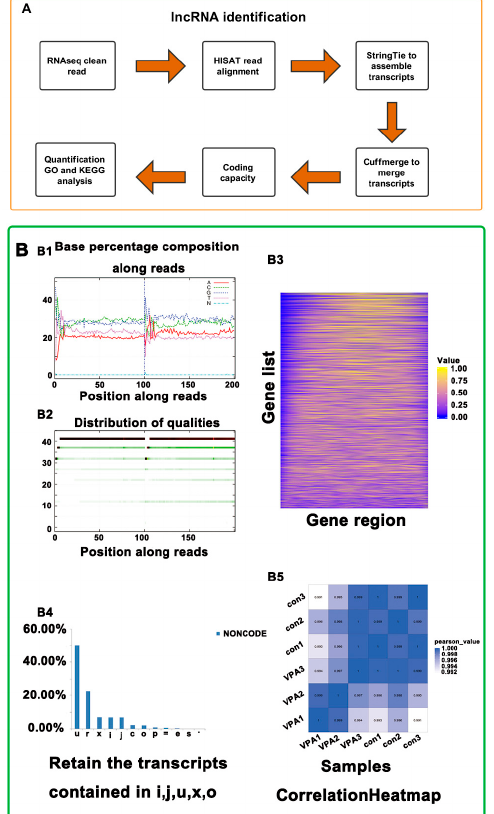
Figure 2. Overview of sequencing RNA (RNA-seq) in hHSC myofibroblasts. Firstly, we employed hierarchical indexing for spliced alignment of transcripts (HISAT) to align clean reads to the human reference genome (hg19/grch37). Secondly, we assembled the transcripts by StringTie for each sample and then used Cufflinks to merge the assembled transcripts. Thirdly, we combined three computational methods, CPC/txCdsPredict/CNCI/Pfam, to distinguish the mRNAs and long noncoding RNAs (lncRNAs) in the assembled transcripts. We applied Bowrie2 to compare clean reads to the reference sequence and then used RNA-Seq by Expectation Maximization (RSEM) to calculate for the expression levels of the genes and transcripts ( A ). To ensure the reliability of further data analysis at each step of data acquisition or analysis process, we applied a specific filter and check, including Base msaa distribution, sample correlation and sequencing depth, to monitor the data quality ( B ), and Figure includes Base distribution ( B1 ), base mass distribution ( B2 ), gene coverage map ( B3 ), lncRNA classification chart from NONCODE ( B4 ) and B5 is sample (con1, con2, con3 and VPA1, VPA2, VPA3 biological duplication) correlation ( B5